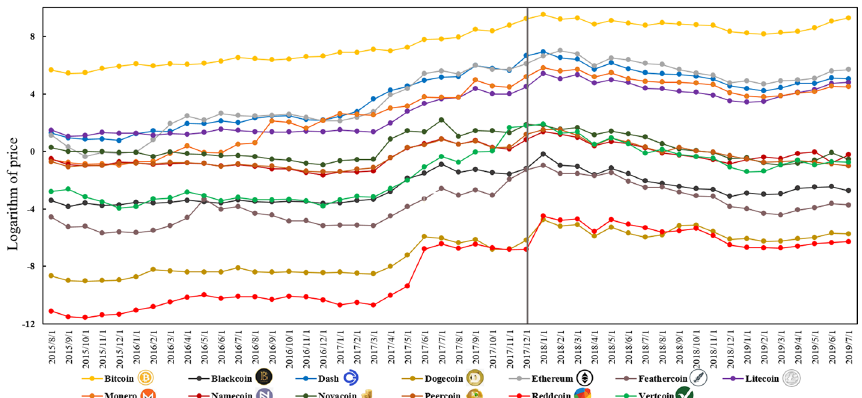
Fig. 2 Price evaluation of 13 cryptocurrencies. Notes : We choose the price of each cryptocurrency on the first day of each month to represent the monthly price. Daily data are used in the remaining parts of this